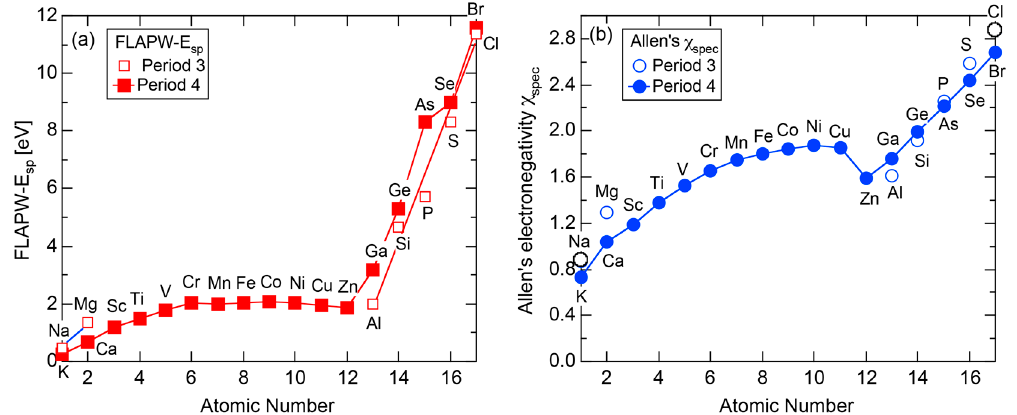
(cid:12) (cid:12) E E E ≡ − and ( b ) Allen (cid:12) (cid:12) A − E A (cid:12) E (cid:12) and s p sp s p